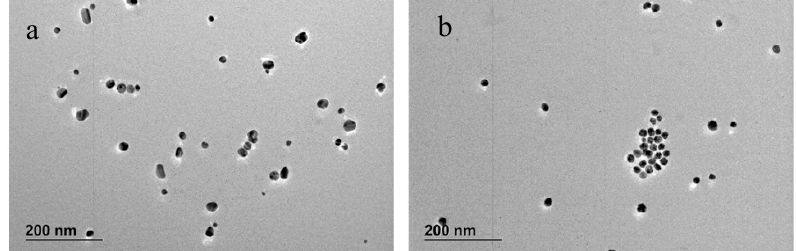
Figure 11. TEM images of AgNPs synthesised by preconditioning the TA at pH 10 for 24 h: the two concentrations of TA were ( a ) 2 × 10 − 6 and ( b ) 2 × 10 − 5 M.